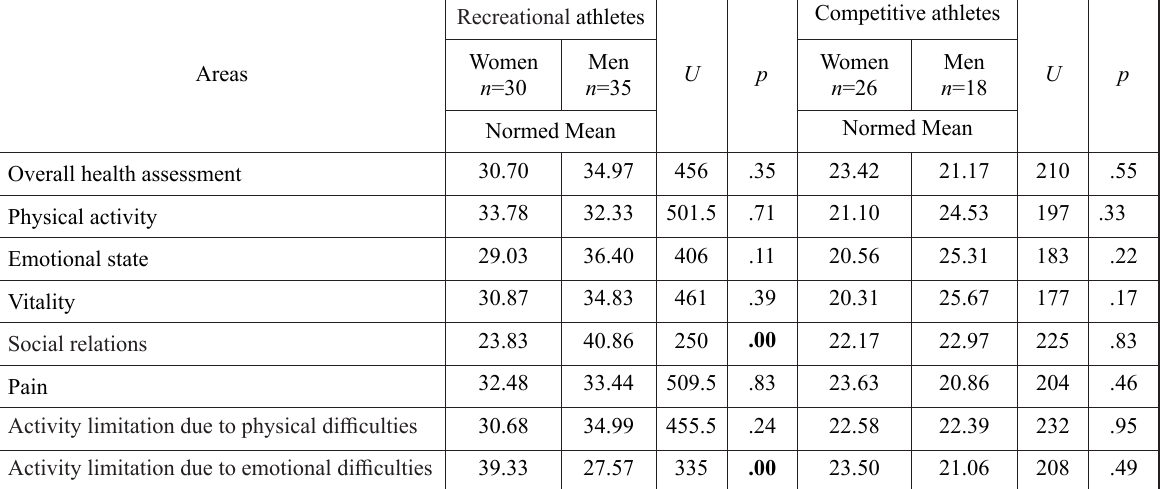
Table 4. Evaluation of HRQL in competitive and recreational male and female athletes